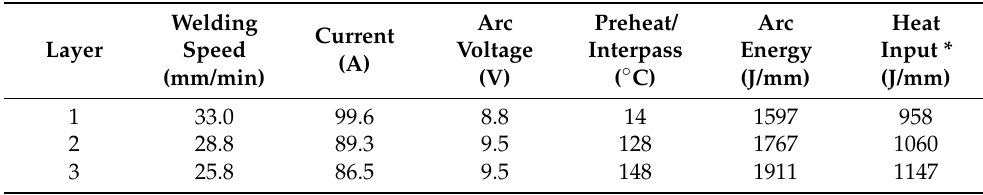
Table 2. Welding procedure characteristics.